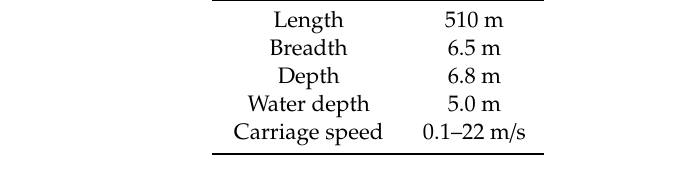
Table 3. Main test instrument.